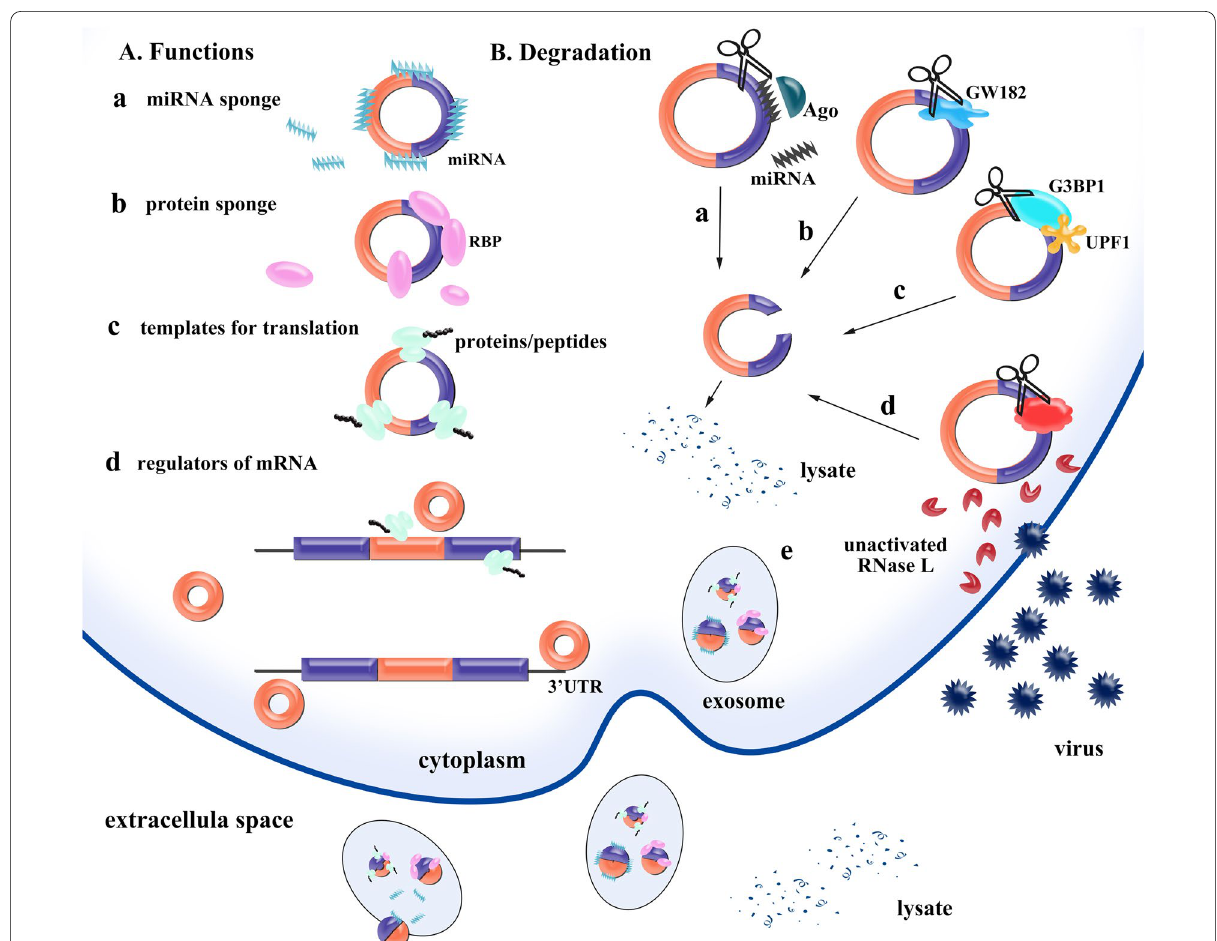
Fig. 2 Functions and degradation of circRNAs. A Functions of circRNAs (a) . CircRNAs play a regulatory role by binding to miRNAs (b) . CircRNAs bind to proteins to act as a protein sponge or a protein scaffold (c) . CircRNAs can be translated into proteins or peptides in cap-independent way, during which IRES or other initial elements are necessary (d) . CircRNAs can be regulators of mRNA, including regulating translation of mRNA